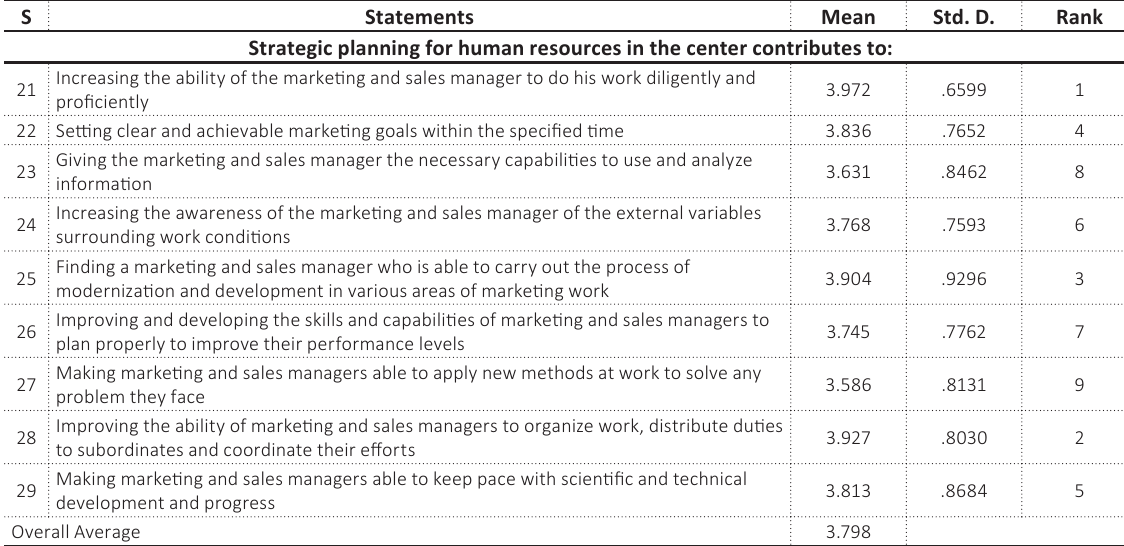
Table 5. Means and standard deviations of the marketing capabilities variable S